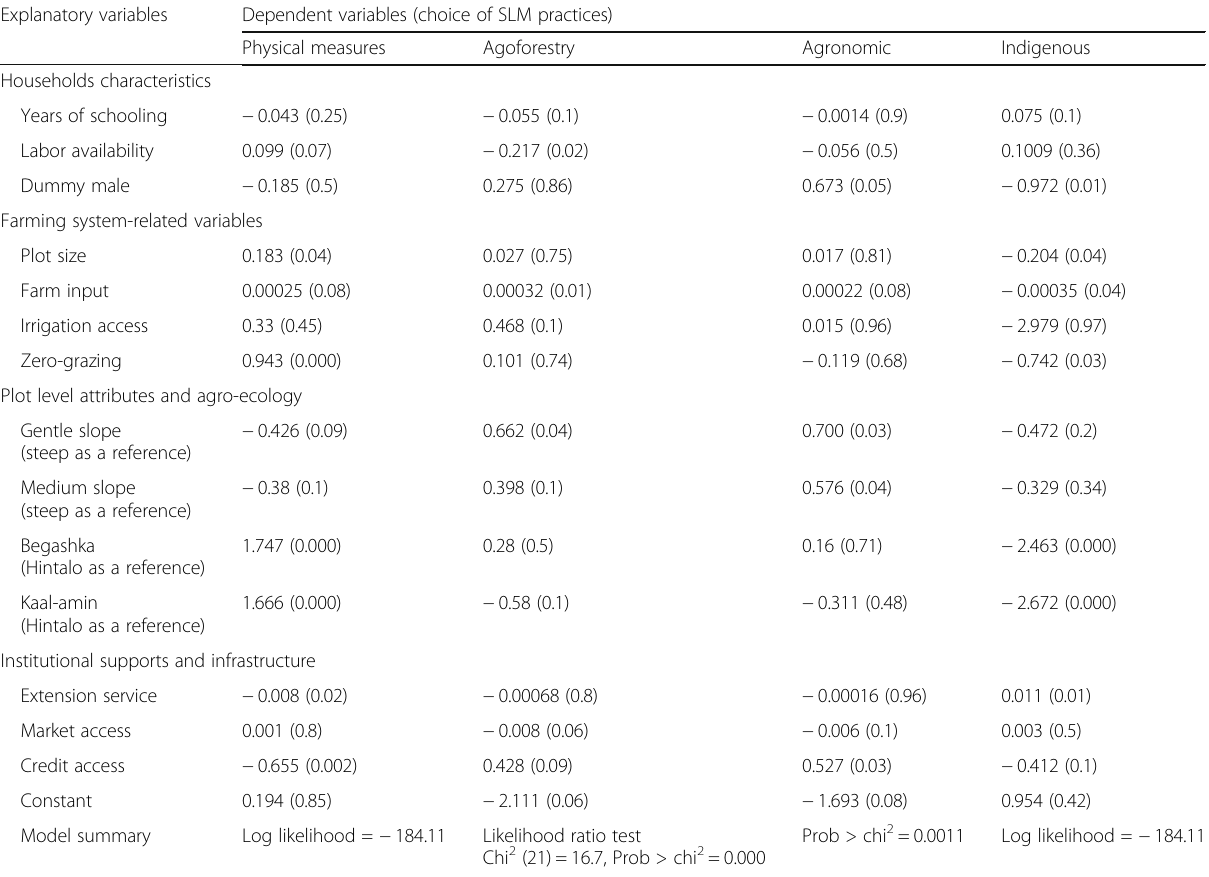
Table 8 Coefficient estimates of the multivariate probit model ( p values in parentheses) Explanatory